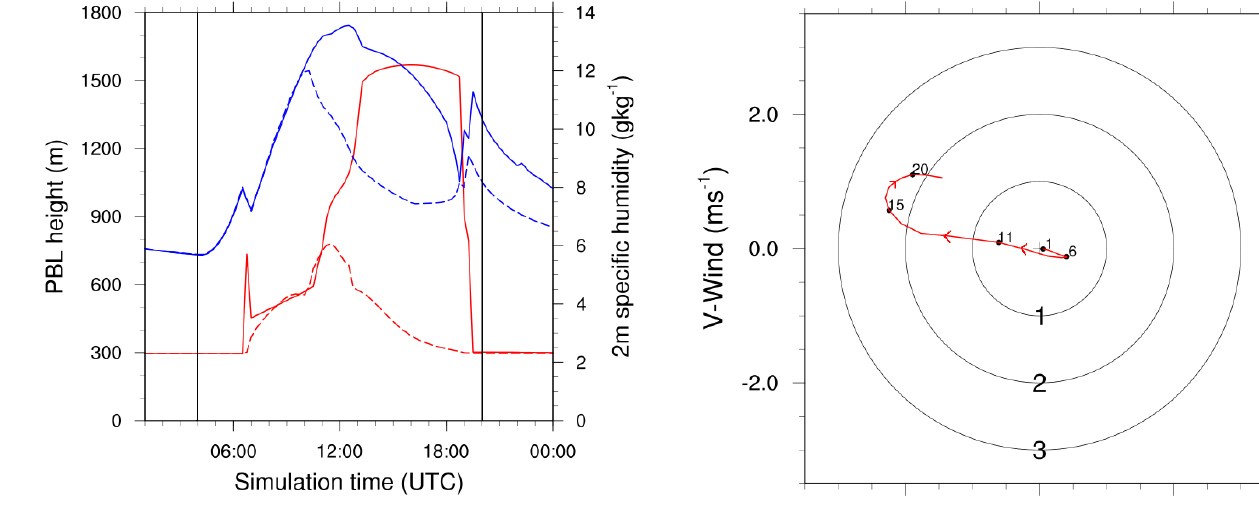
Fig. 7. Daytime evolution of PBL height (red) and 2m specific humidity (blue) for the baseline single coast simulation using the YSU PBL scheme and an SST of 287K. Solid lines indicate values 150km onshore and dashed lines are at the coastline. Sunrise and sunset times are represented by the solid vertical black lines